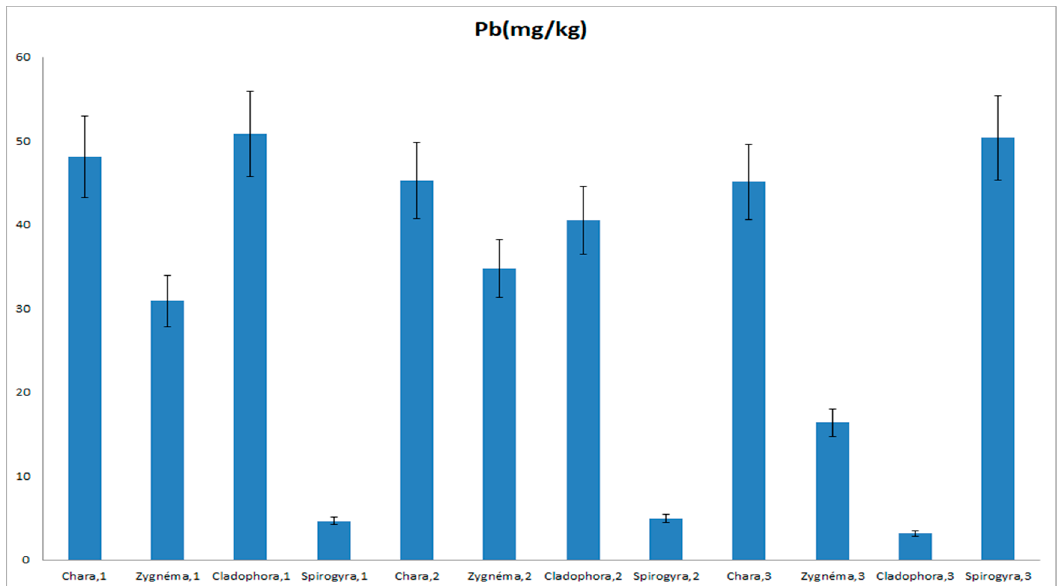
Figure 6. Pb contents of the four algae studied (for the three sites considered).